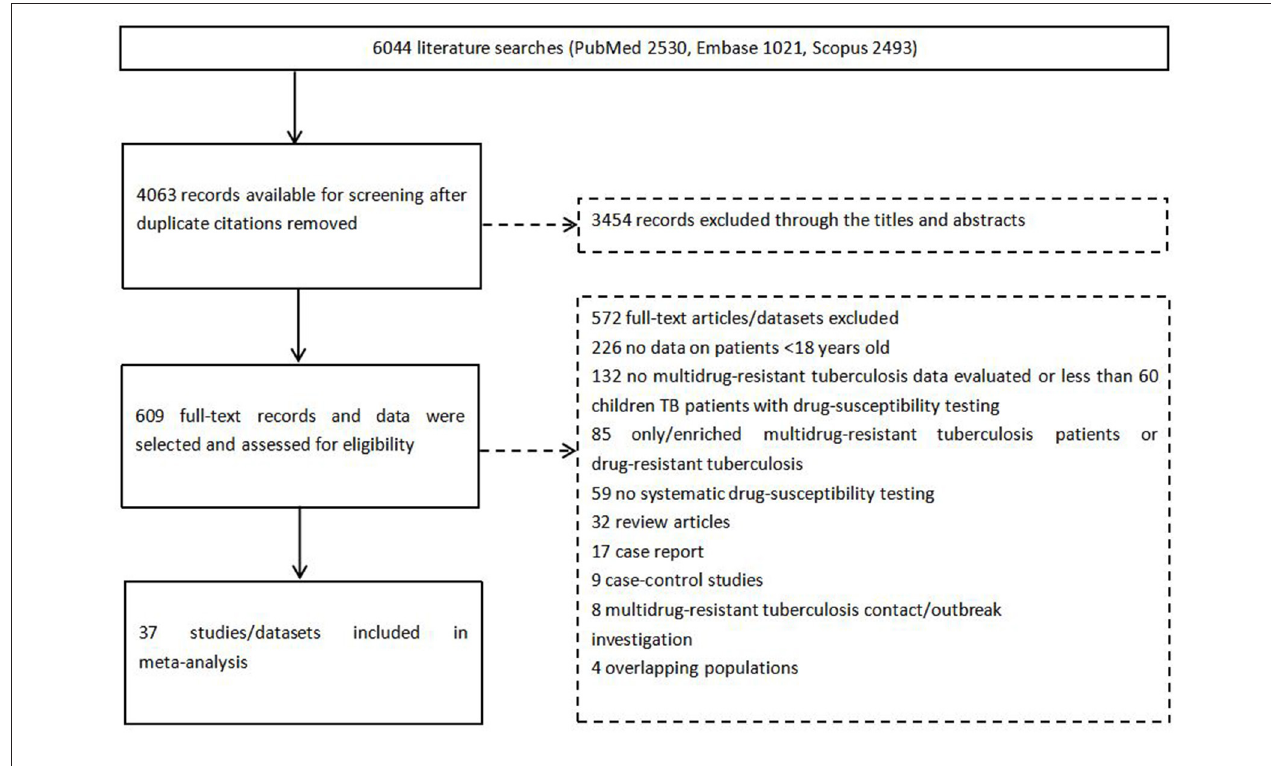
FIGURE 1 | Flow chart for study selection. TB, tuberculosis.